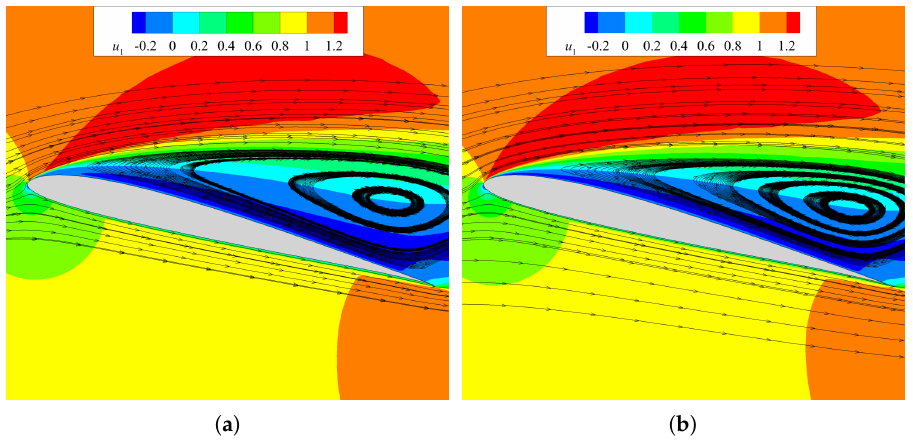
Figure 12. Stationary case. Contour of streamwise velocity u 1 . SA − BCM model ( a ) and SA model ( b ).